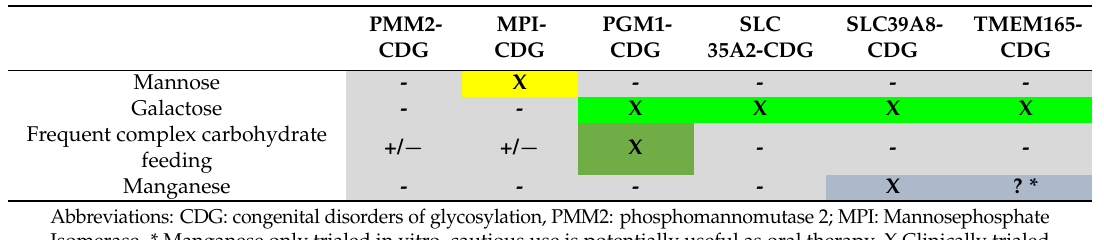
Table 1. Specific dietary treatments in N -linked disorders of